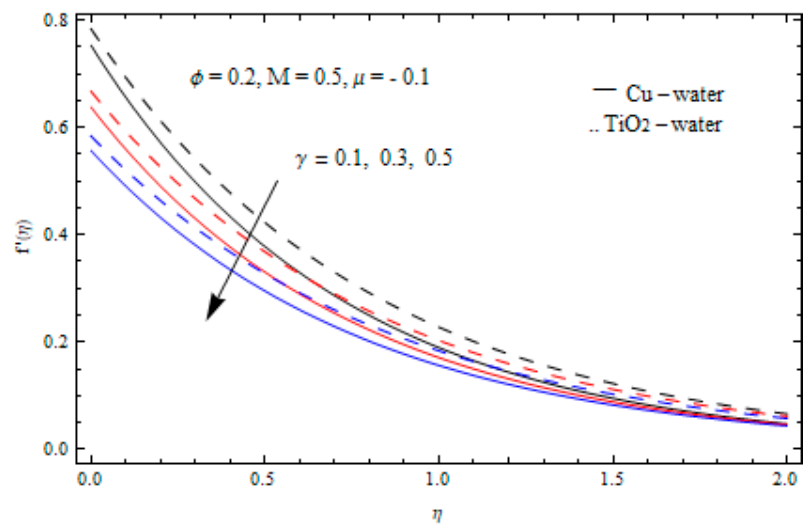
γ on velocity of Cu-water and TiO 2 -water nanofluids. Figure 4. Effect of first slip